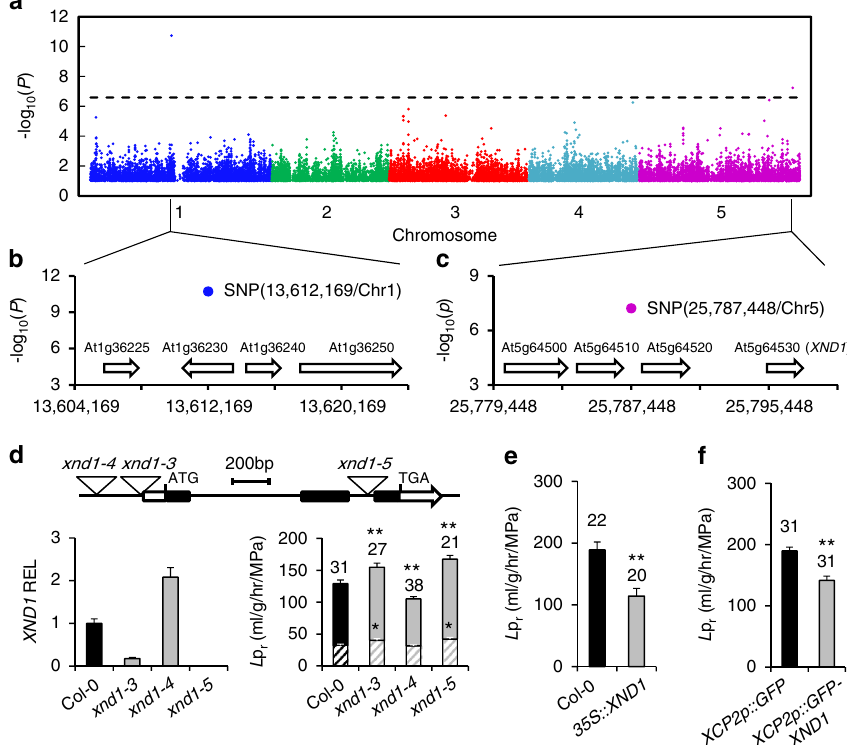
Fig. 1 Identi fi cation of XND1 as a genetic determinant of root hydraulic conductivity. a Manhattan plot of GWA for root hydraulic conductivity ( L p r ) data based on a conditioned accelerated mixed-model. The chromosomes are depicted in different colors and the x -axis represents the chromosome number and position. A Bonferroni corrected signi fi cance threshold at α = 0.05 is indicated by the horizontal dashed line. b , c Gene models of 20-kb genomic regions surrounding the two most signi fi cantly associated SNPs. The blue and purple dots represent these SNPs, and numbers on x- axes indicate chromosomal positions in base pairs. d Molecular and phenotypic characterization of three xnd1 T-DNA insertion lines. The upper diagram shows a schematic representation of the XND1 genomic region with positions of the three T-DNA insertions. The bar graph on the left shows XND1 transcript abundance relative to Col-0 (relative expression level, REL) in the xnd1 lines (means ± SE, based on two biological repeats). The bar graph on the right shows L p r phenotypes before (whole bars) or after (hatched bars) root treatment for 30 min with the aquaporin blocker NaN 3 . e , f L p r phenotype of Col-0 transgenic lines with XND1 constructs under control of a CaMV35S ( e ) or a xylem speci fi c XCP2Pro ( XCP2p ) ( f ) promoter. In f , plants expressing GFP alone under the control of XCP2Pro were used as negative controls. In all panels, L p r data (means ± SE) were based on the indicated number of plants in two to three independent experiments. Asterisks indicate signi fi cant differences with respect to control lines (Student ’ s t test; * P < 0.05, ** P <